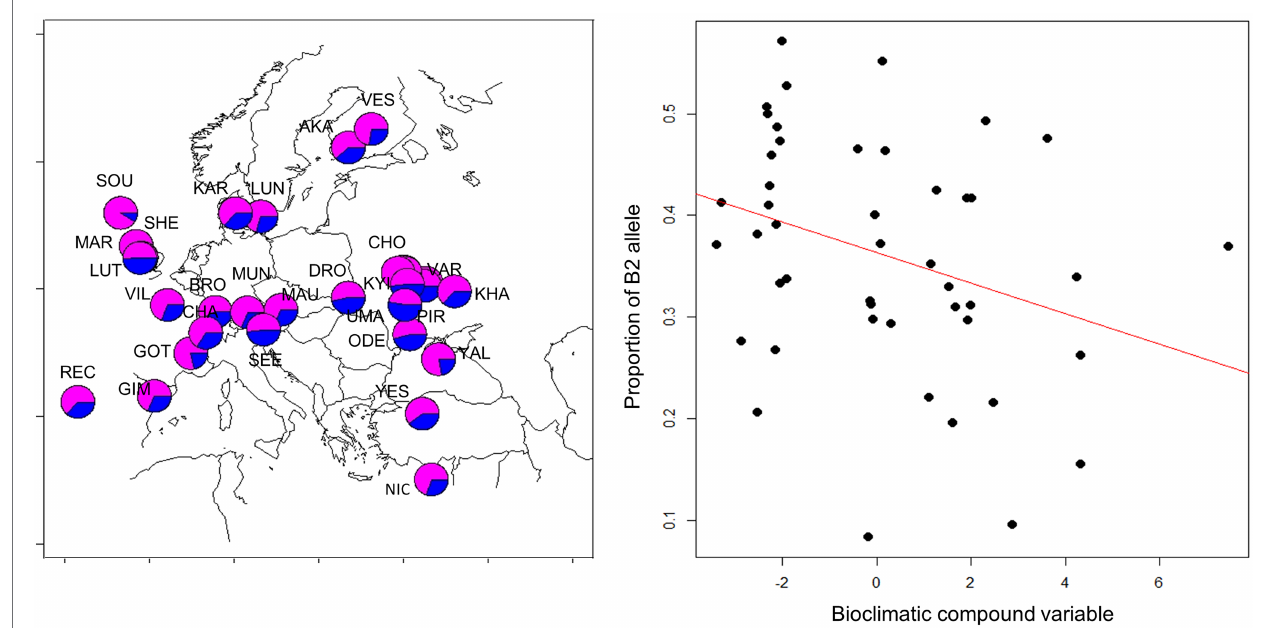
FIGURE 10 | Geographical distribution of B1/B2 cry polymorphism. Frequency of the 12 bp indel in European populations is shown on the left (deletion: blue; insertion: magenta). Population samples were collected in 2014 and were previously described (Kapun et al., 2020). Population codes are depicted and are listed in Supplementary Table S5 . Each population sample consisted of 50 flies, from which DNA was extracted, and subjected to next-generation sequencing of the pooled DNA (Kapun et al., 2020). Allele frequency in each sample was estimated by analyzing 37–139 sequencing reads spanning the B1/B2 indel. The frequency of the B2 allele (with the deletion) is highly correlated with a compound bioclimatic variable ( z = − 4.85, p = 1.22E-06, df = 46; see text for